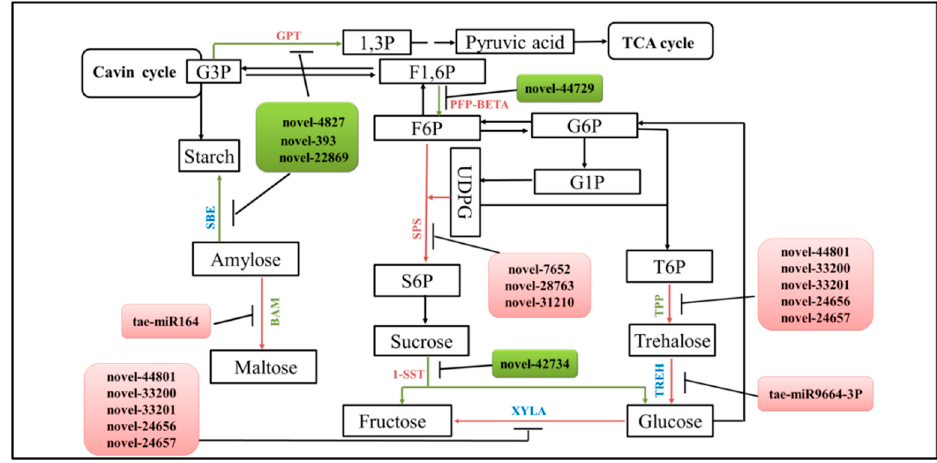
Figure 6. The key carbohydrate metabolic pathway and the miRNA–mRNA interactions in dmc. Pink: highly expressed in dmc ; green: lowly expressed in dmc ; blue: no difference in expression between dmc and WT. G3P: glycerol-3-phosphate transporter 1 (At3g47420); SBE: 1,4-alpha-glucan-branching enzyme (SBE1); Beta-amylase (BAM); PEP-BETA: pyrophosphate-fructose 6-phosphate 1-phosphotransferase subunit alpha (PEP-BETA); SPS: sucrose-phosphate synthase 4 / 5 (SPS4 / SPS5); 1-SST: sucrose 1-fructosyltransferase (1-SST); XYLA: xylose isomerase (XYLA); TPP: trehalose-phosphate phosphatase 2 (TPP2); TREH:trehalase(TREH);F6P:fructose-6-phosphate; G6P:glucose-6-phophate;